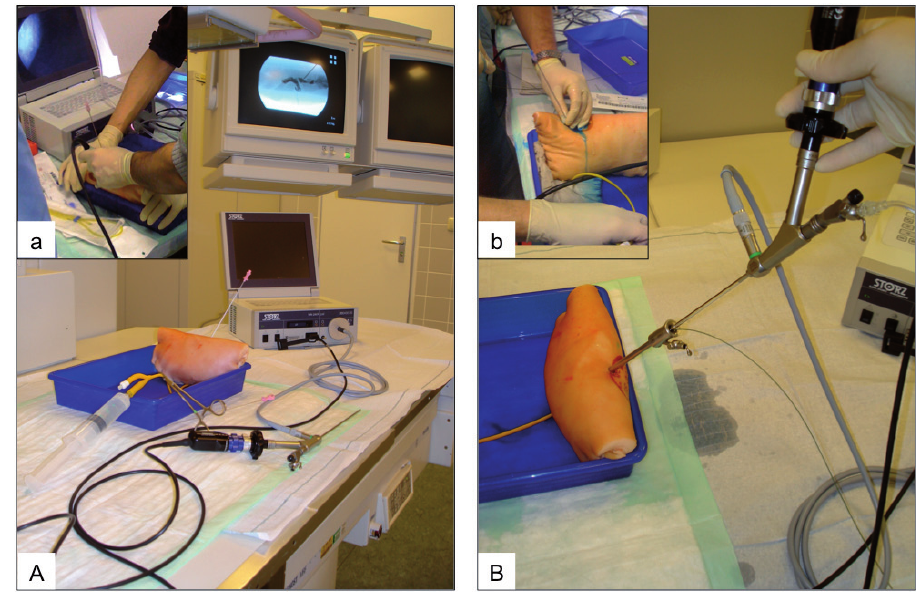
Figure 4 - Puncture of the renal pelvis (A) and subsequent intrarenal surgery (B). Alter- nate ultrasound guided puncture (a) and verification of successful access to the renal pelvis by blue dye irrigation is depicted